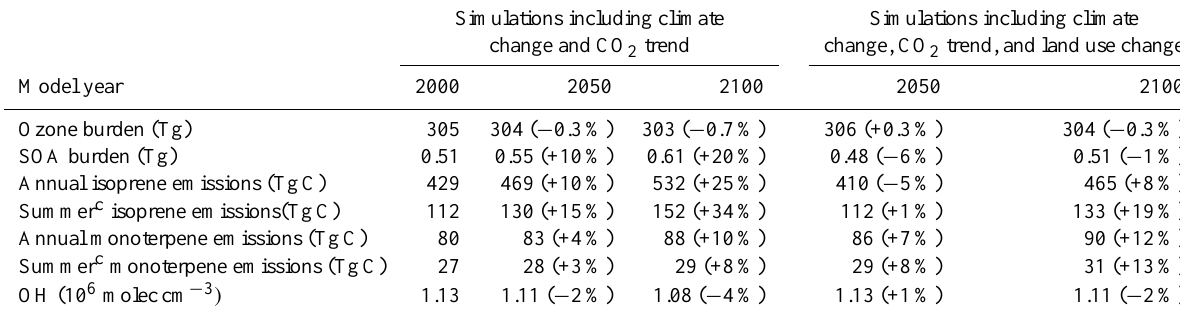
Table 1. Changes in biogenic emissions and atmospheric composition a , b . Simulations including climate Simulations including climate change and CO 2 trend change, CO 2 trend, and land use change Model year